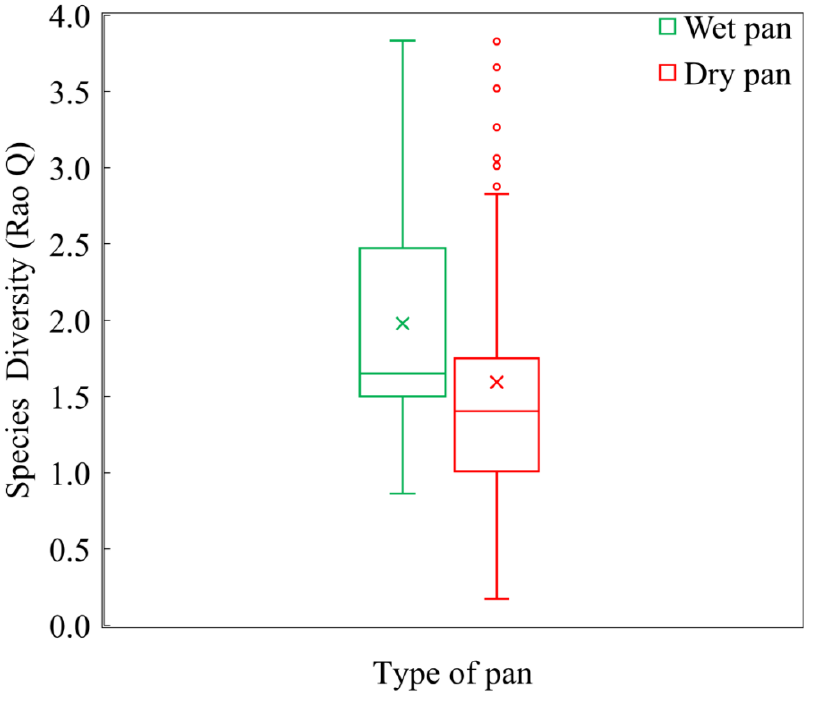
Figure 7. Mean variation in remotely sensed diversity (Rao’s Q) between wet and dry natural pans